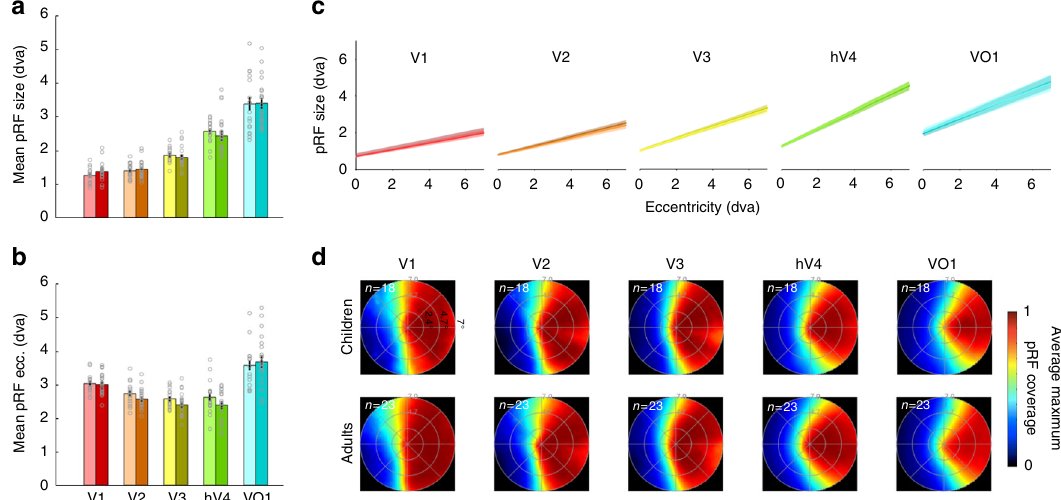
Fig. 2 pRF properties in V1 – VO1 are quantitatively similar across development. a Mean pRF size in V1 – VO1 across 18 children (light colors) and 23 adults (dark colors); Error bars: standard error. Gray circles: individual participant data. Each circle is a participant. b Mean pRF eccentricity in V1 – VO1 of the same participants. Gray circles: individual participant data. c pRF size vs. eccentricity relationship is similar across age-groups. The line of best fi t (solid line) and the standard error (shaded region) illustrates the relationship between pRF eccentricity and size in units of degrees of visual angle (dva). Adults are shown in dark colors ( n = 23), children ( n = 18) in light colors (each age group is shown in a separate graph in Supplementary Fig. 7). Fits are calculated in each participant, slopes and intercepts are then averaged across participants. d Visual fi eld coverage of V1 – VO1 computed using the average maximum pRF density coverage for each participant and then averaged across participants. Maps are averaged across hemispheres by fl ipping the right hemisphere data. Top: children. Bottom: adults. Number of participants is indicated in the top-left of each panel. Inner to outermost ring segments correspond to 2.4, 4.7, and 7 degrees of visual angle (dva)